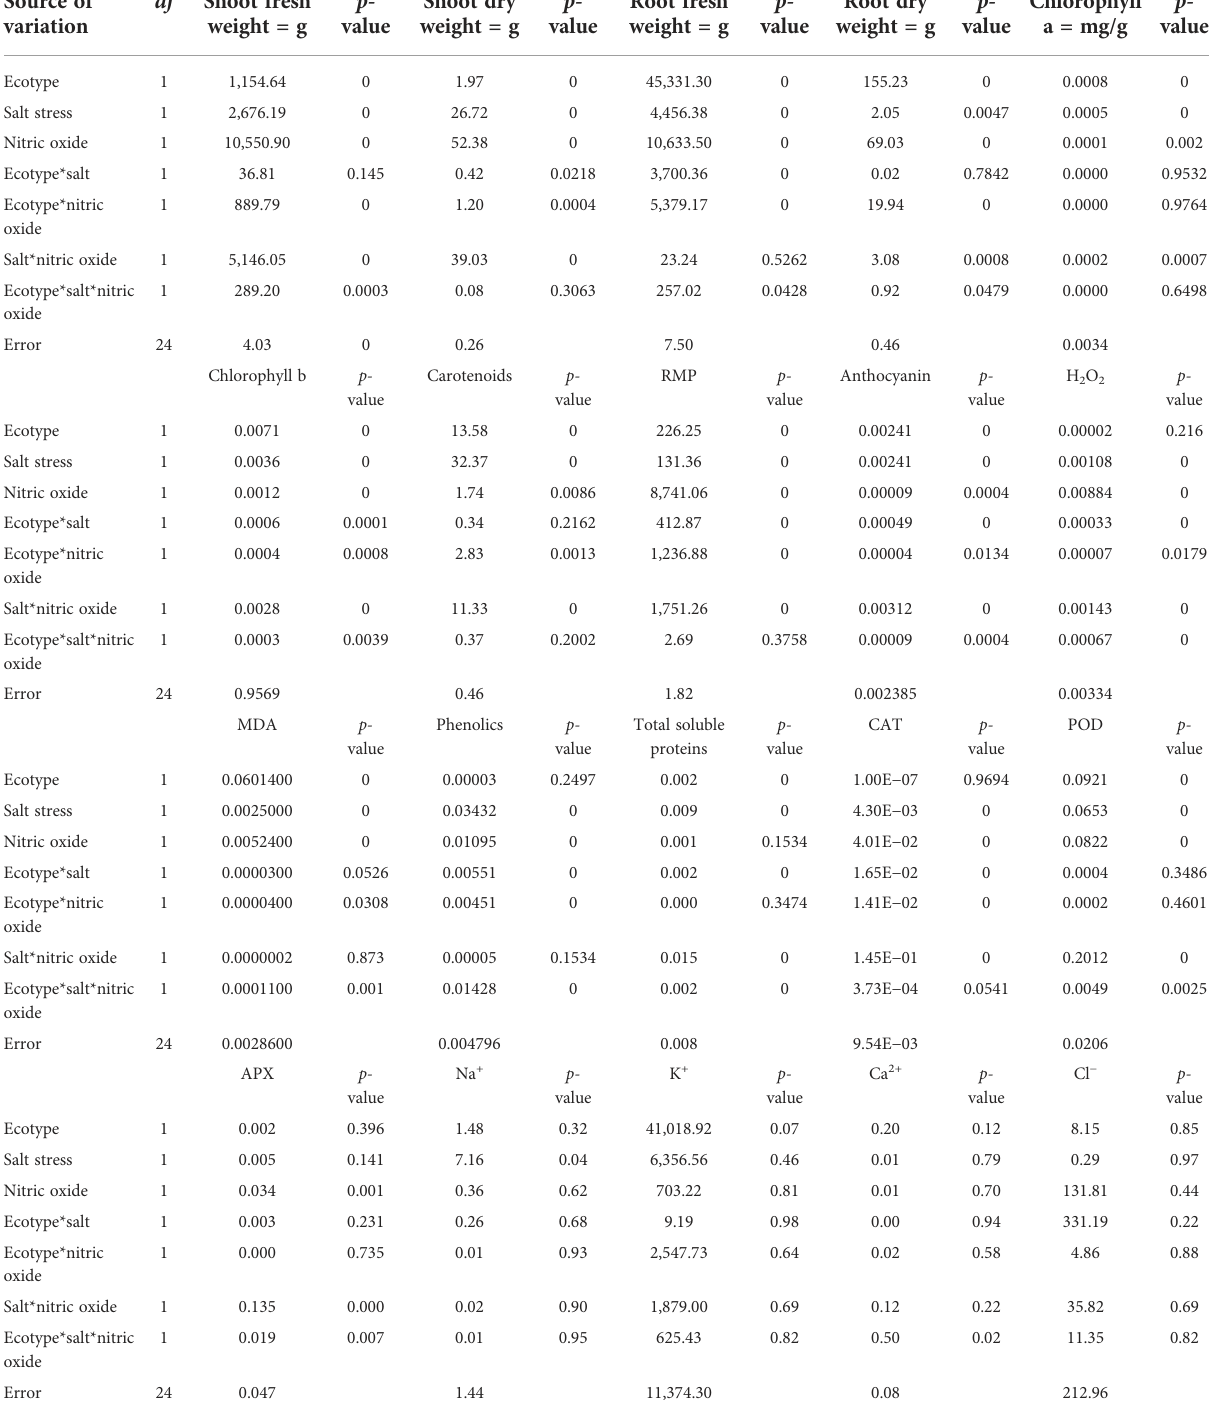
TABLE 1 Mean square values from ANOVA of the data on the different physiological and biochemical parameters of the two ecotypes of turnip ( Brassica rapa L.) grown for 42 days under salt stress and nitric oxide effect. Source of